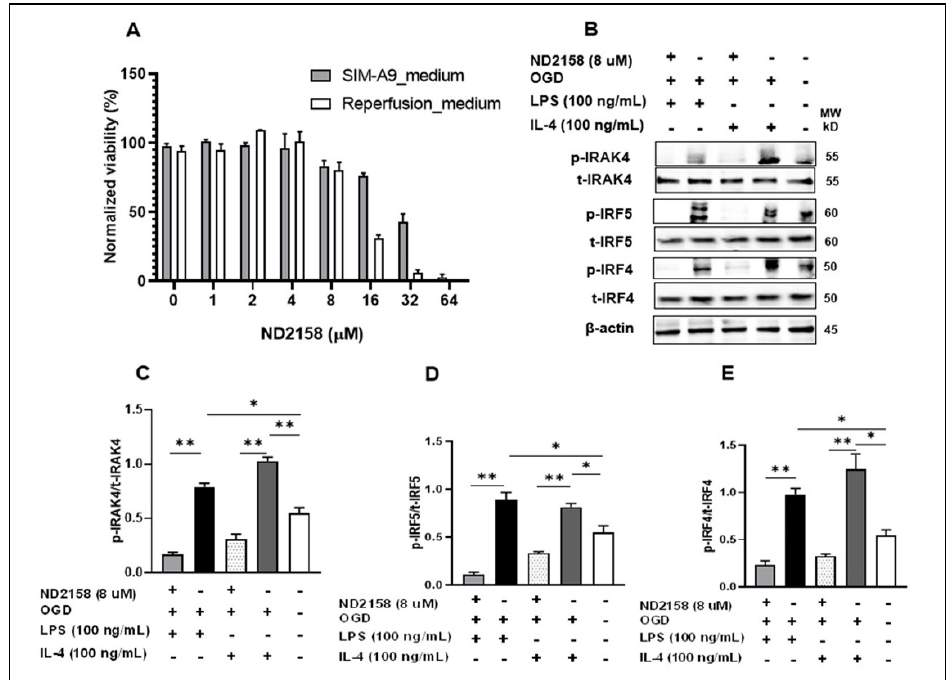
Figure 2. IRAK4 phosphorylates IRF5/IRF4. ( A ) SIM-A9 cells were treated with 8 μM ND2158, chosen by MTS gradient viability assay. ( B ) After treatments, cell homogenates were immunoblotted. ImageJ quantified ratios of p-IRAK4/t-IRAK4 ( C ), p-IRF5/t-IRF5 ( D ), and p-IRF4/t-IRF4 ( E ) in ( B ). Data were obtained from 3 independent experiments. p, phosphorylated; t, total. Arrows ** p < 0.0001, * p < 0.05; One-way ANOVA.